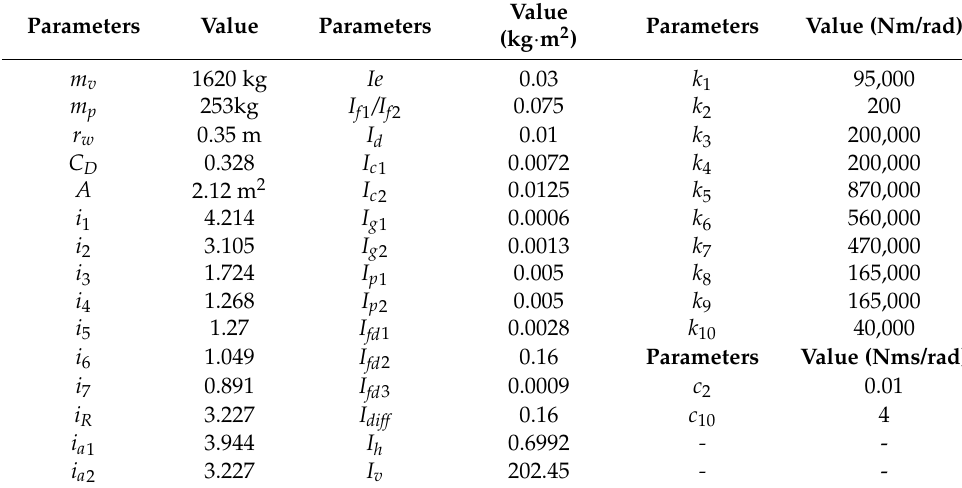
Table A1. Powertrain model parameters.